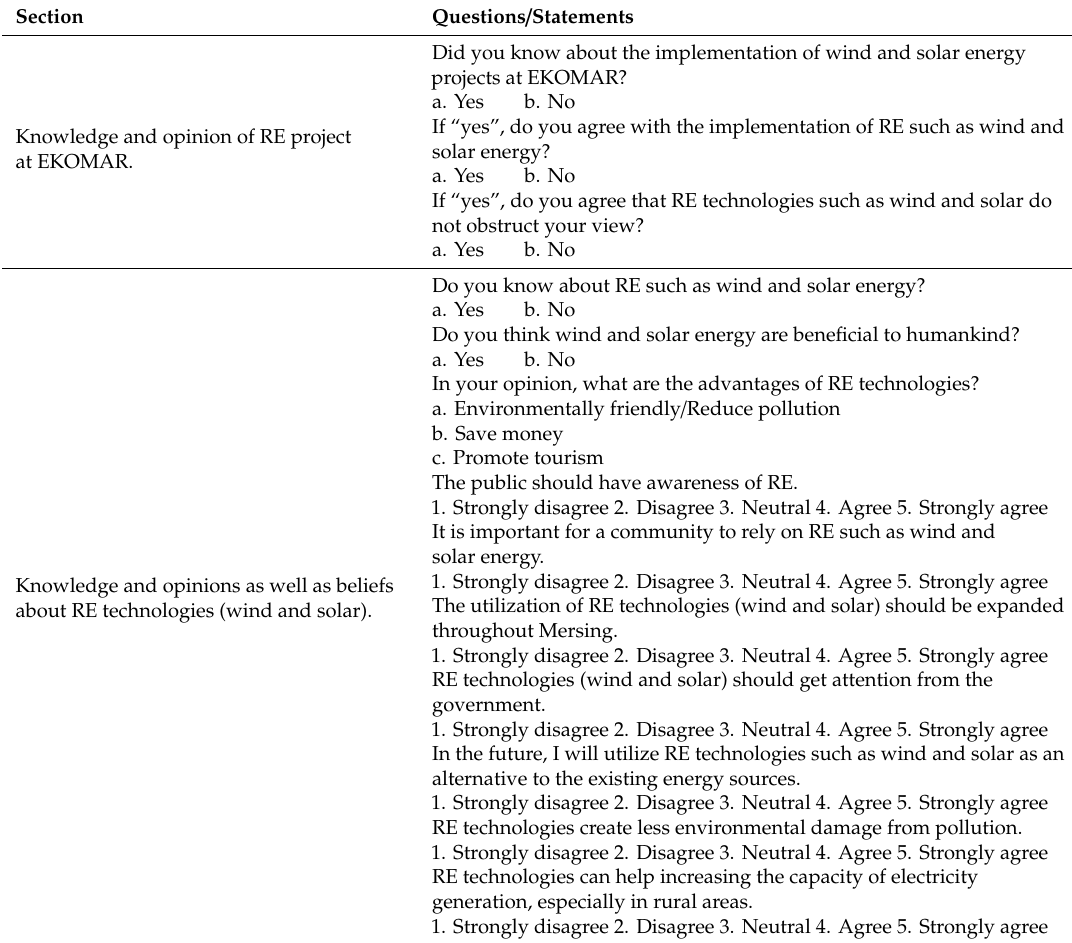
Table 3. Questions for second survey (after EKOMAR project